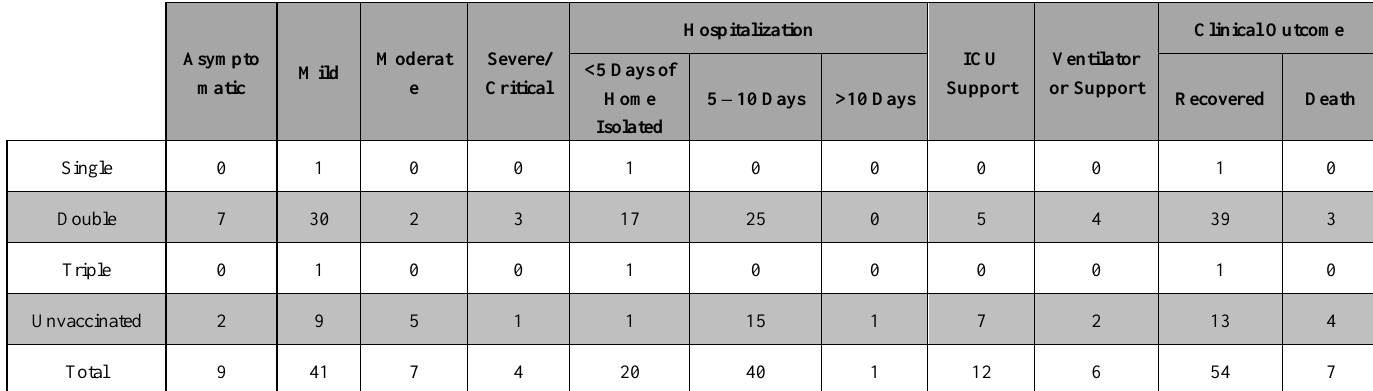
Table 5. Clinical severity with respect to vaccination.